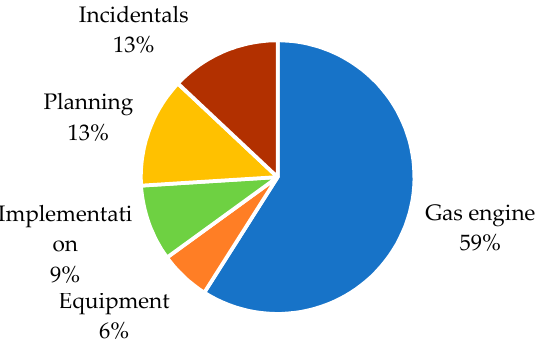
Figure 4. Distribution of investment costs for a cogeneration project [41].